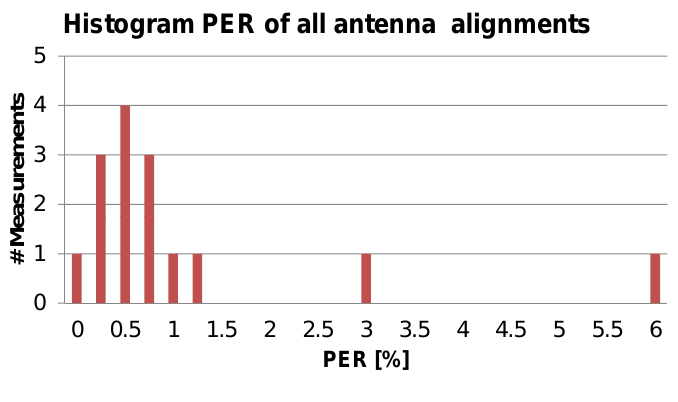
Figure 11. Histogram of packet loss rate (PLR) during the 15 × 10-min measurements of all three antenna alignments of IPANEMA generation 2.